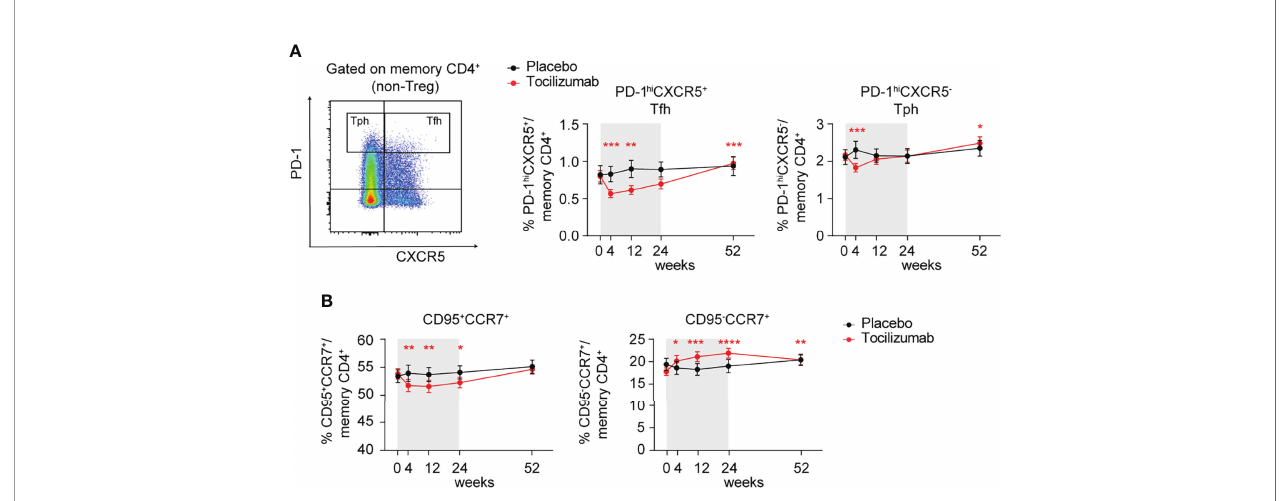
FIGURE 6 | Tocilizumab treatment decreases the frequency of PD-1 hi CXCR5 + Tfh cells and modulates FAS/CD95 expression on memory CD4 + T cells. (A, B) Individuals enrolled in the EXTEND study were treated with tocilizumab (red line) or assigned to the placebo group (black line) and changes in T cell phenotypes were assessed over time via fl ow cytometry. (A) Representative fl ow plot (left) of gating strategy to de fi ne PD-1 hi CXCR5 + Tfh and PD-1 hi CXCR5 - Tph cells and (right) changes in frequencies of Tfh and Tph cells over time. Time frame of tocilizumab treatment during 24 weeks is indicated by gray shading. (B) Frequencies of CCR7 + CD95 + and CCR7 + CD95 - memory CD4 + (non-Treg) T cells over time in the tocilizumab-treated versus placebo group. (A, B) Plots show mean values and error bars indicate the standard error of the mean (SEM). Signi fi cance between pre-treatment baseline (week 0) and respective visits was calculated through the Wilcoxon matched pairs signed rank test. (A) n = 23-26 (placebo group); n = 50-53 (tocilizumab group). (B) n = 24-26 (placebo group); n = 50-53 (tocilizumab